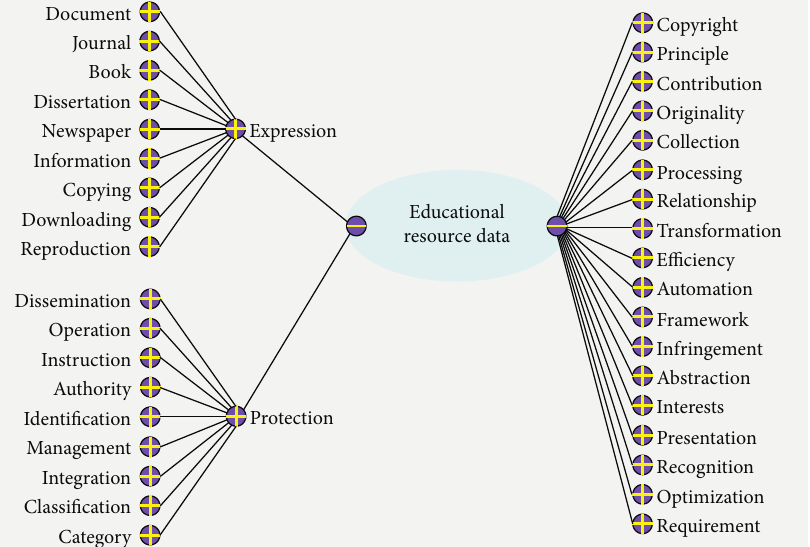
Figure 4: Intellectual property protection rule management of educational resource data based on machine learning.